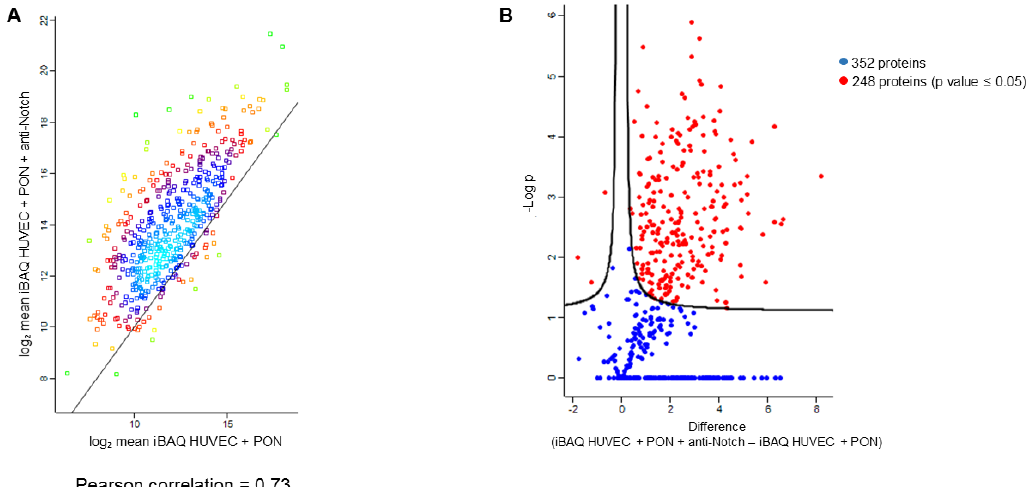
Figure A1. Volcano plot showing the proteins that are differentially expressed in the HUVECs treated with 1.7 nM ponatinib in the presence or absence of 1 μg/mL neutralizing factor anti-Notch-1 antibody. ( A ) Density plot showing mean Pearson correlation of average iBAQ between the two cellular treatments. ( B ) Dot plot representing the proteins di ff erentially expressed in the two cellular